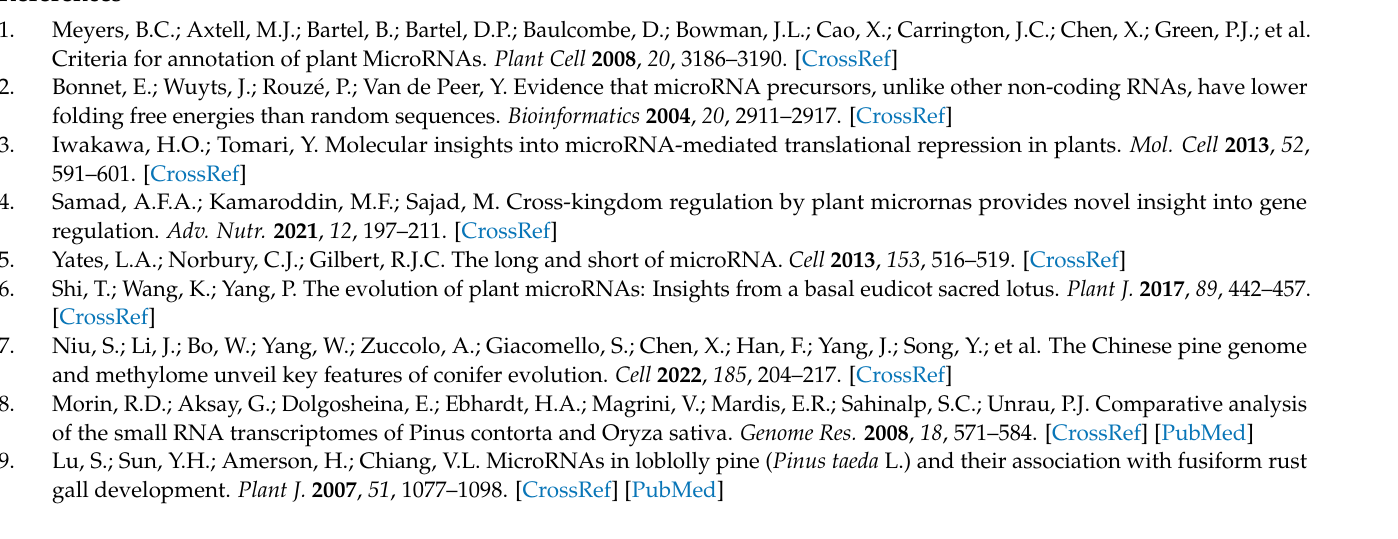
different categories; Table S4: Reference transcriptome comparison statistics; Table S5: Identification Table S7: Identification of novel miRNAs in Chinese fir; Table S8: Novel miRNA targets and their putative function; Table S9: The expression of novel and known miRNAs; Table S10: The number of miRNAs and the family in known MIRNA from Chinese fir; Table S11: The number of novel miRNAs in Chinese fir; Table S12: The length of miRNA precursor from Chinese fir; Table S13: The number Table S15: The novel miRNA (n = 105) targets and their putative function in this study; Table S16: The relationship of MFE between pre-miRNA and its corresponding mature